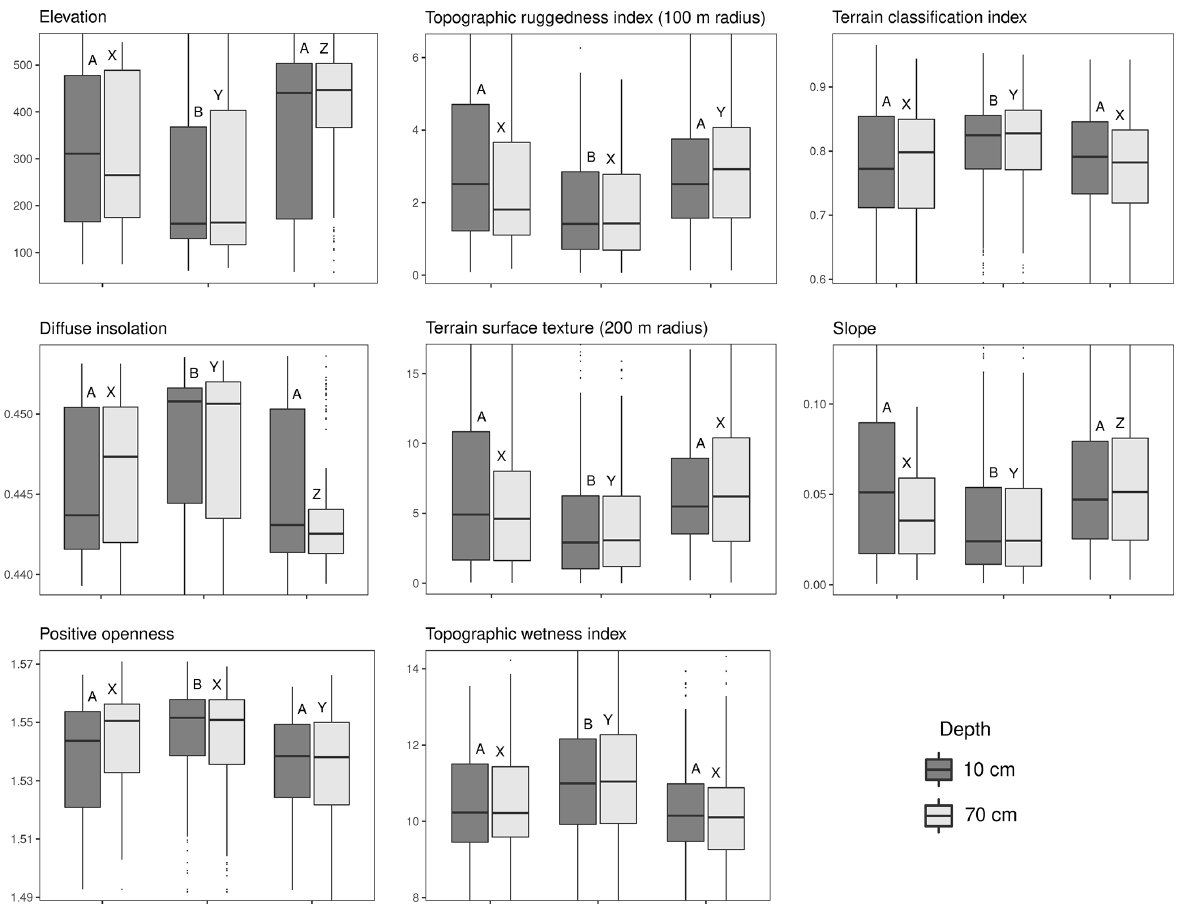
Figure 5. Data distribution of selected predictors per soil texture cluster and soil depth. Letters above boxplots denote significance groups within one depth level. The y axes are cropped to highlight the interquartile